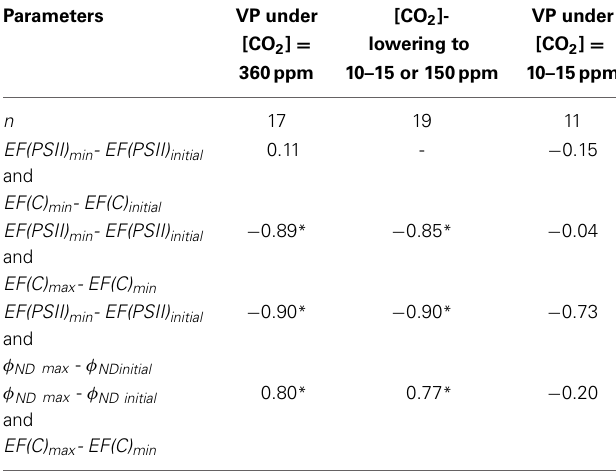
EF(C) under different CO 2 concentrations ( Figure 8 ). EF(C) and NPQ were taken from the Tables 1 , 4 (unheated plants). Figure 8 shows that EF(C) and NPQ were linearly